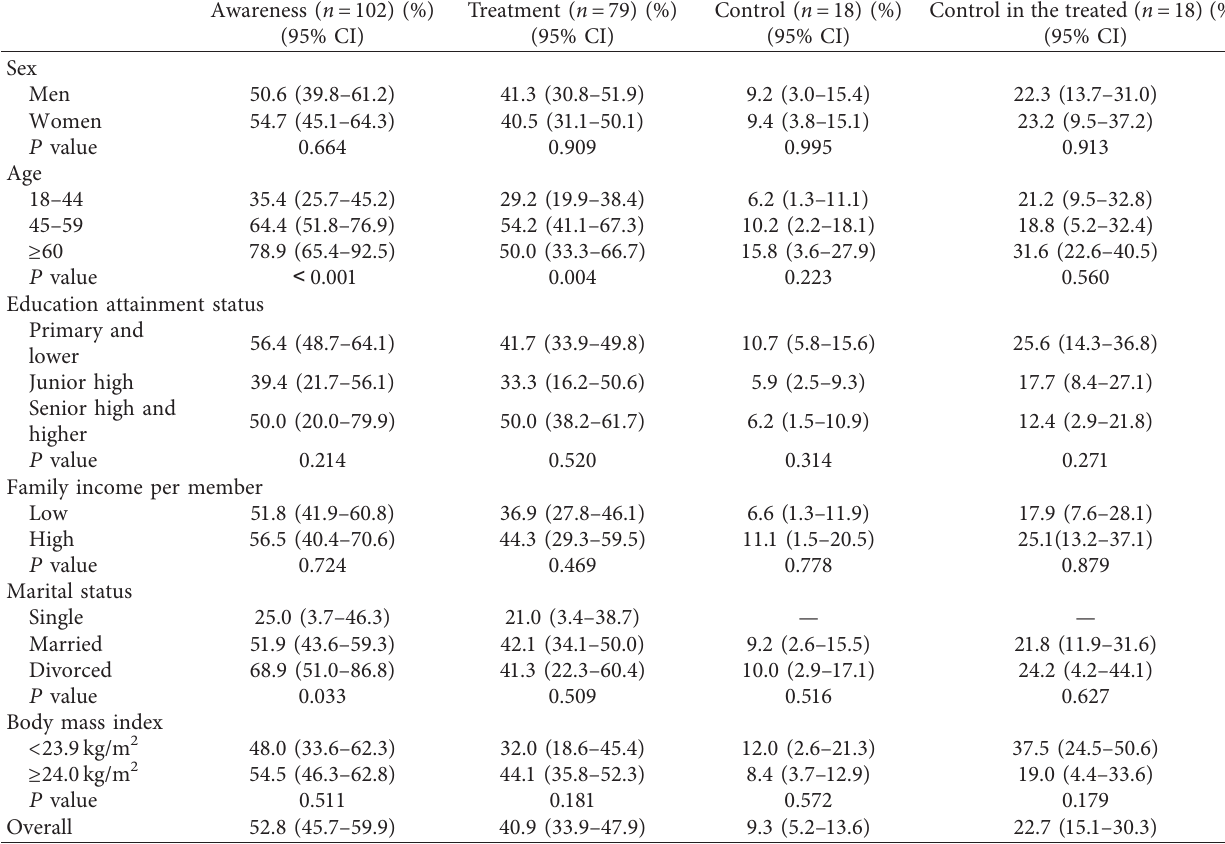
Table 3: Awareness, treatment, and control of hypertension in the study